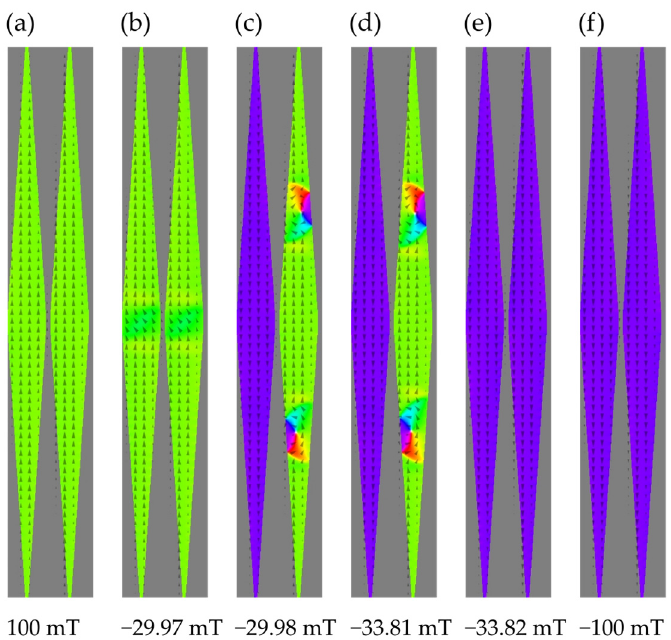
Figure 7. Switching process FM → dAF → rFM at the distance d = 40 nm. ( a ) saturated FM ( b ) visible precursor deviation of magnetization in the central part, ( c , d ) left diamond entirely reversed, pair of vortices in the right diamond, ( e ) configuration rFM just after reversal, ( f ) saturated rFM at the largest negative applied field.